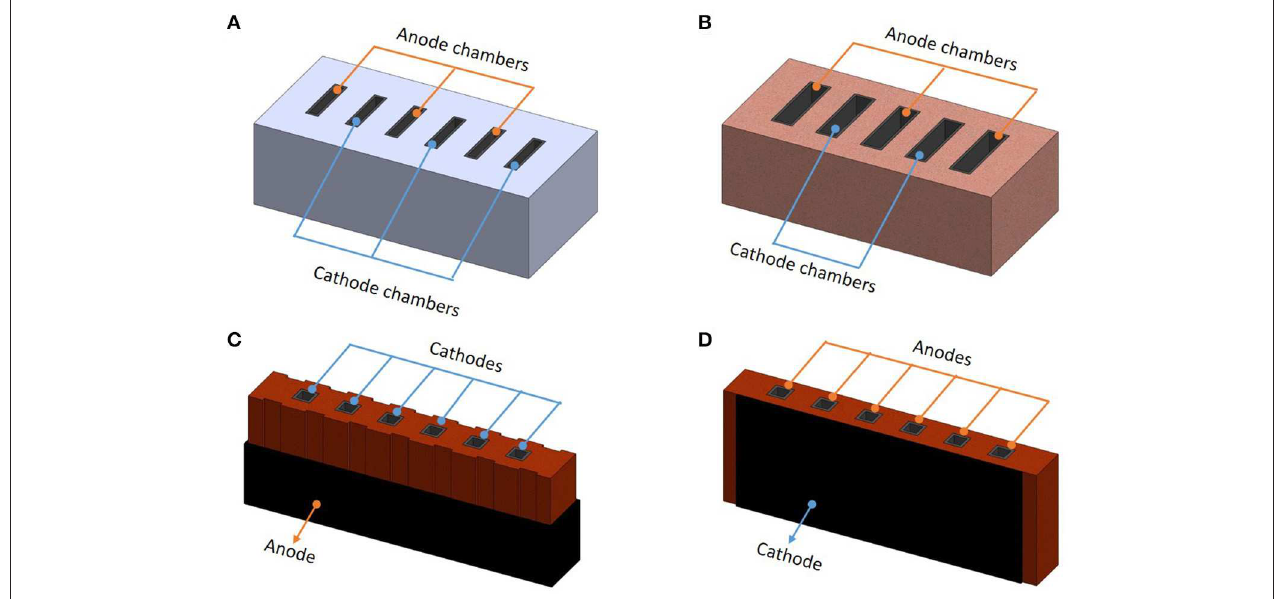
FIGURE 1 | Schematic diagrams of the tested brick MFCs: (A) Type 1 brick B MFC with three anode chambers and three cathode chambers. (B) Type 1 brick R MFC with three anode chambers and two cathode chambers. (C) Type 2 brick O MFC with one external anode and six internal cathodes. (D) Type 2 brick O MFC with two external cathodes and six internal